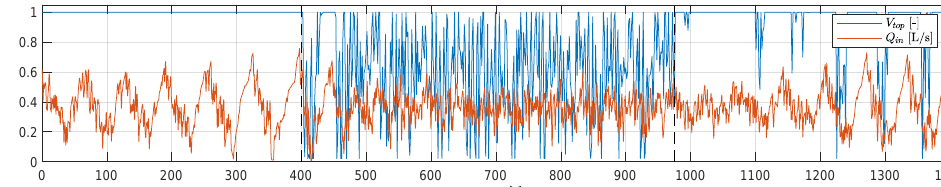
Figure 4. Shows Q in and V top during experiment 1. V top starts fully open and reduces its opening degree to 20% open at 400 s. As a result, the slug is